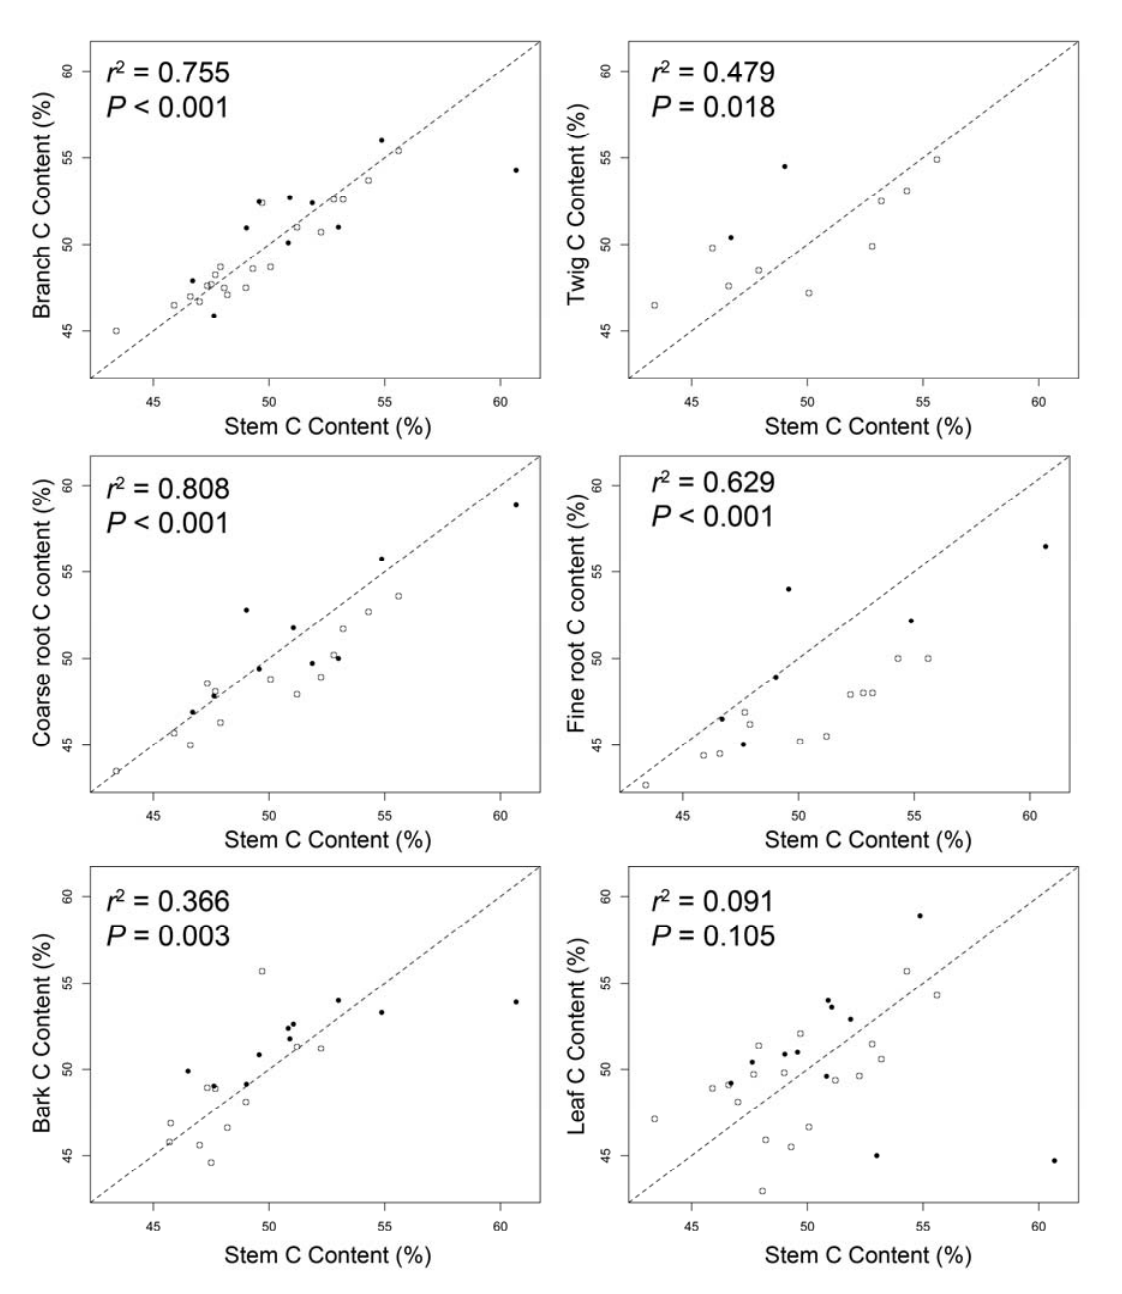
Figure 4. Carbon content of major tree biomass components as a function of the carbon content of carbon content of main stem wood, based on data compiled from the literature review. Standard major axis regressions do not differ significantly from a 1:1 relationship (shown as dotted lines) in any case; open circles indicate angiosperms and closed circles conifers. The species Pinus massoniana (with a stem C content of 60.7%—data from [63]) is an outlier for several relationships. Excluding this species increases the r 2 value for branch, bark, and leaf comparisons (analyses excluding Pinus massoniana —branch C: r 2 = 0.816; p < 0.001; coarse root C: r 2 = 0.722; p < 0.001; fine root C: r 2 = 0.460; p = 0.003; bark C: r 2 = 0.383; p = 0.003; leaf C: r 2 = 0.307; p =